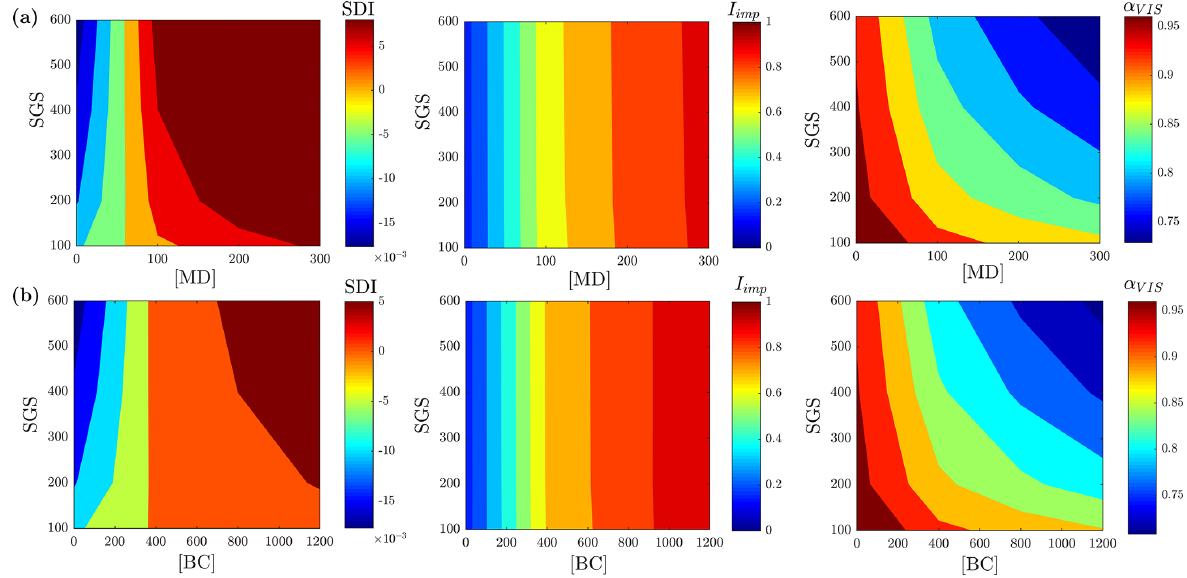
Figure 8. Comparison between SDI, I imp and α VIS obtained from SNICAR simulations. The indices are represented as contour plots as a function of the concentration of mineral dust (MD, row a ) and black carbon (BC, row b ). MD concentrations are in ppm, and BC concentrations are in ppb.